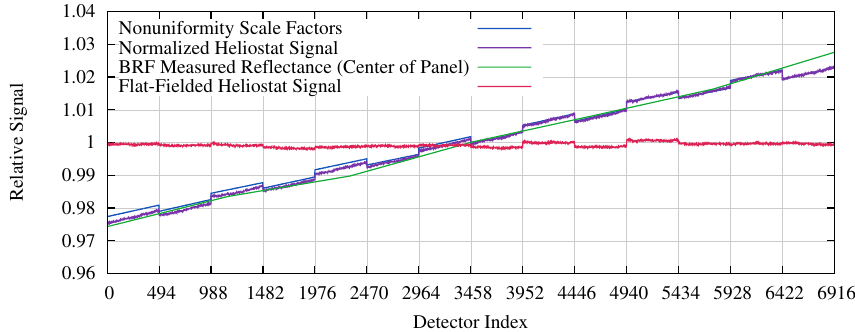
Figure 5. Working diffuser panel relative nonuniformity as viewed by the OLI sensor in the NIR band, fitted response and measured diffuser reflectance at center of panel and 0° azimuth. Note that the nonuniformity scale factors were calculated from an average of seven heliostat collects, so do not flat-field a single collect